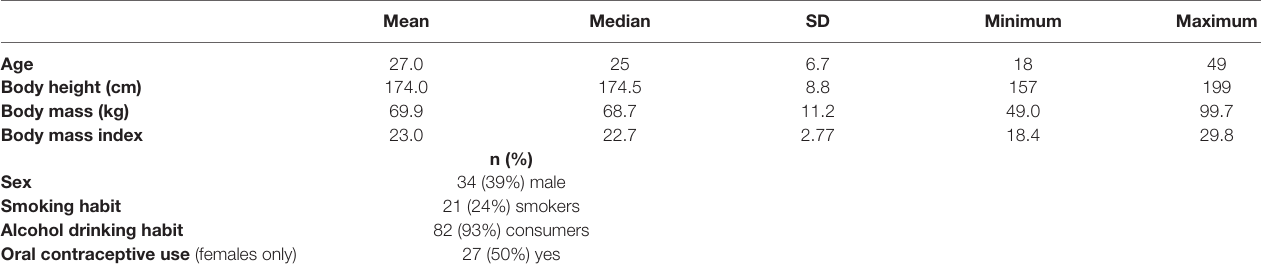
TABLe 1 | Characteristics of the study population (n =